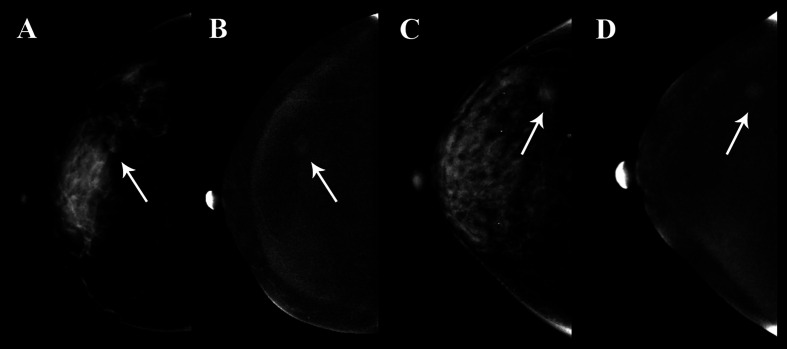
Clinical use of two patients who were both diagnosed with BI-RADS 4B category. The breast lesions of the two patients had similar imaging features on the contrast-enhanced spectral mammography (CESM) images, and the arrow points were the lesions of the two patients. (A, B) A 35-year-old woman, whose malignancy probability was calculated less than 10% by nomogram, was confirmed as fibroadenoma by pathological examination. (C, D) A 41-year-old woman, whose malignancy probability was calculated at about 62% by nomogram, was confirmed as invasive ductal carcinoma by pathological examination.